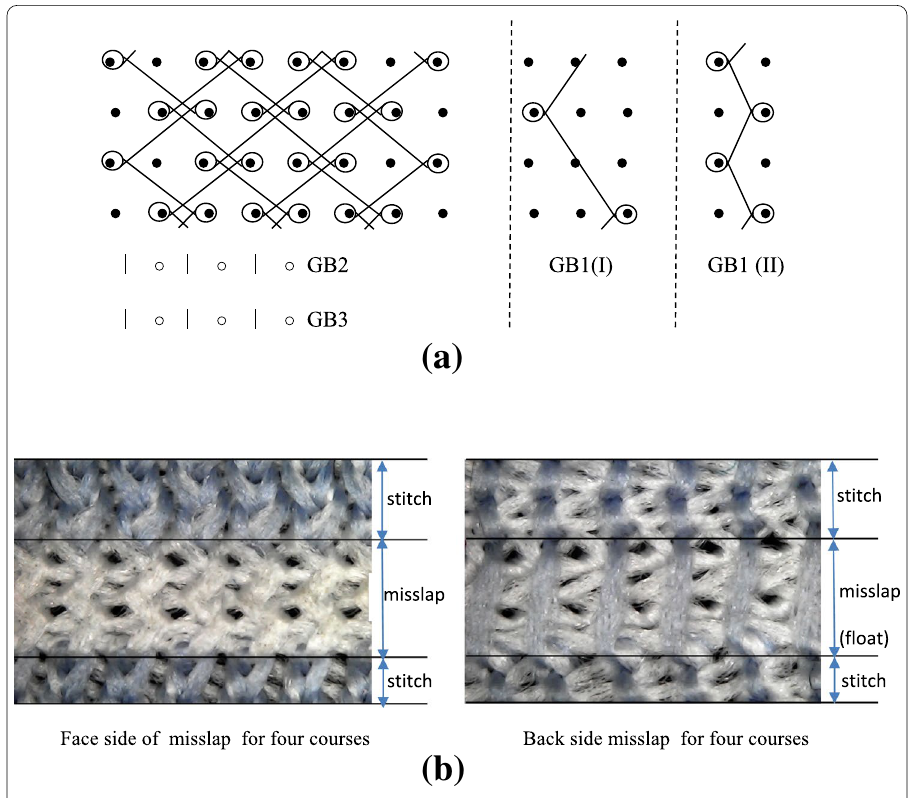
Fig. 1 The lapping diagram of structure I and structure II (“ ∣ ” represents a threaded guide; “ ○ ” represents an empty